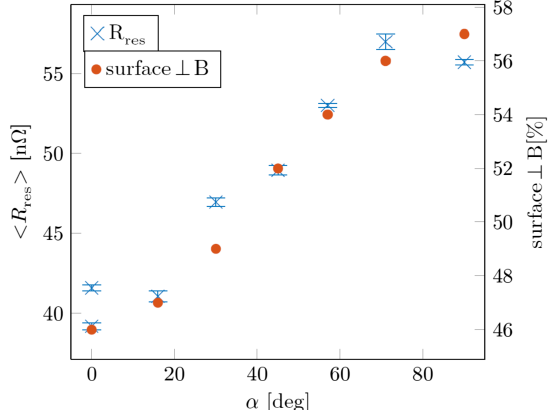
FIG. 8. Measured residual resistance, and percentage of the ⃗ B cavity ’ s surface perpendicular to weighted with H 2 of the rf field. There are two data points for measured residual resistance at α ¼ 0 ° since the field is applied in φ ¼ 0 ° and φ ¼ 90 ° with α ¼ 0 °. The lower point corresponds to φ ¼ 90